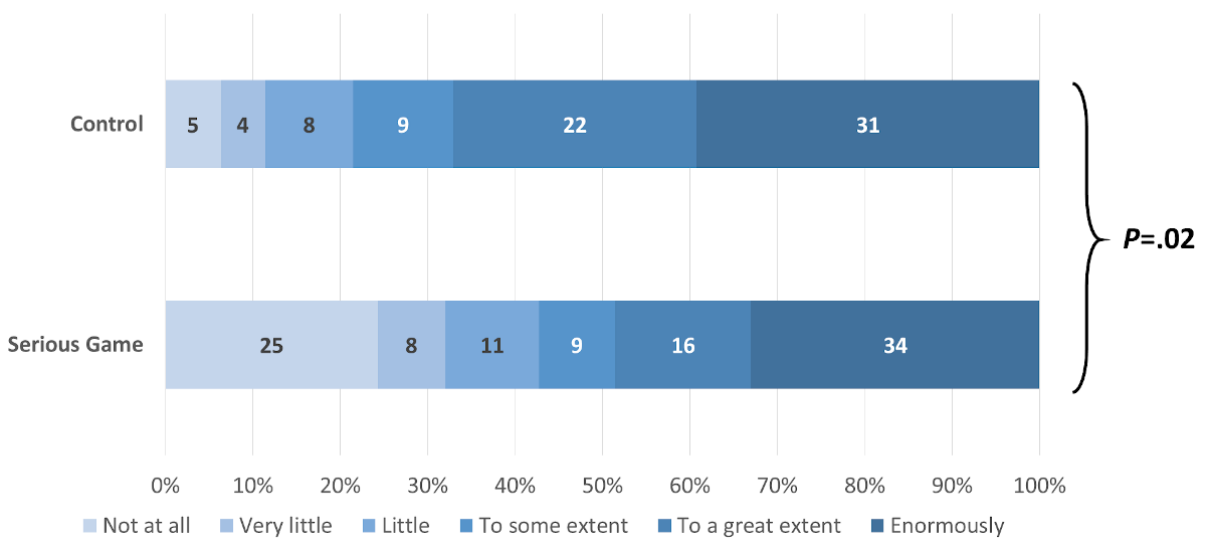
Figure 11. Magnitude of the willingness to change face mask handling